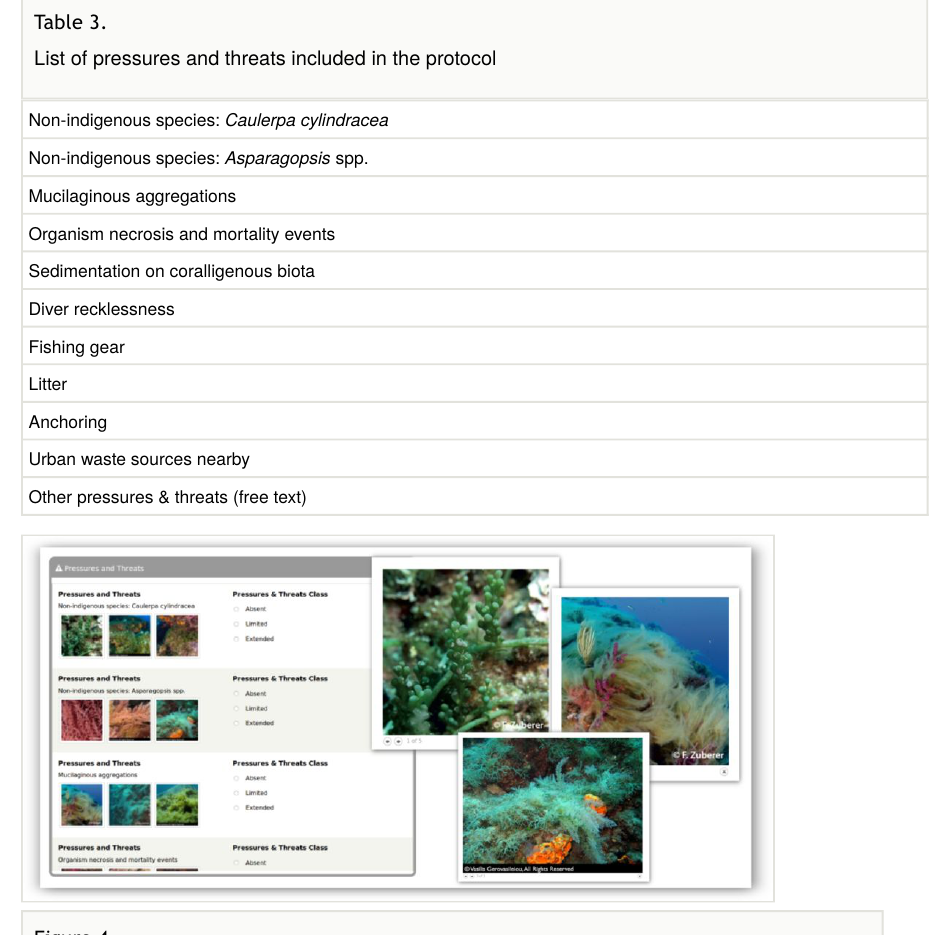
Reporting the intensity of pressures and threats on the CIGESMED for divers